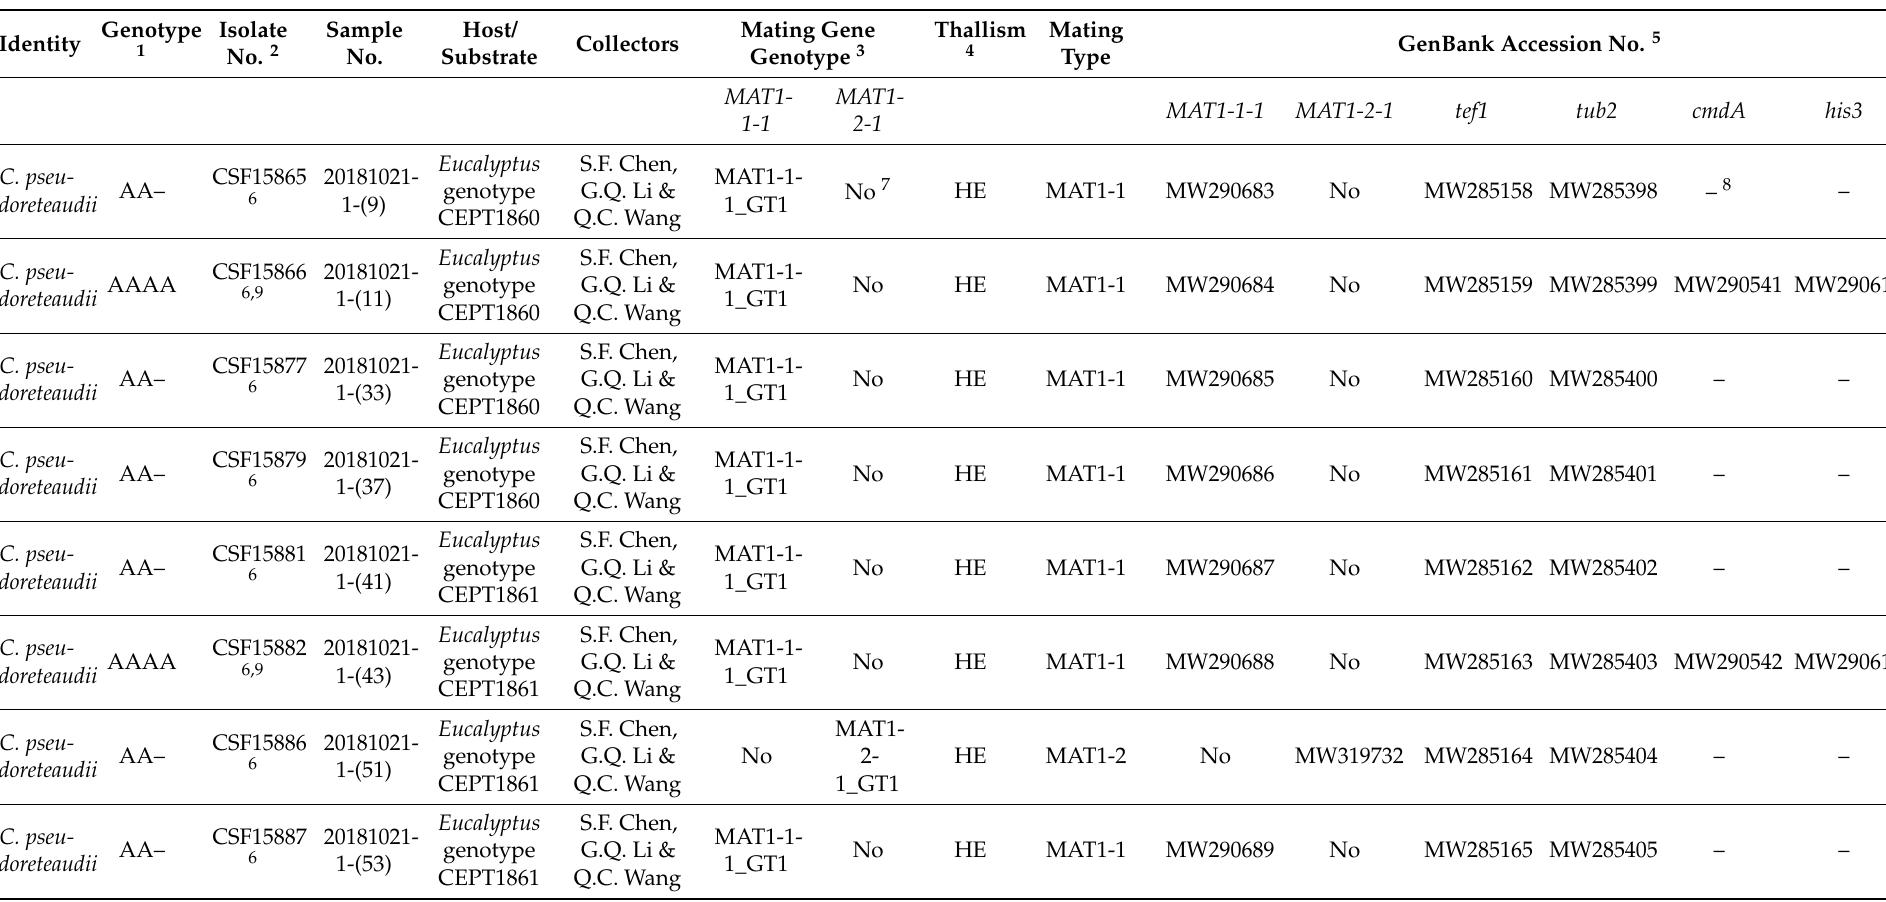
Table A1. Isolates sequenced and used for phylogenetic analyses, mating studies, morphological studies and pathogenicity tests in this